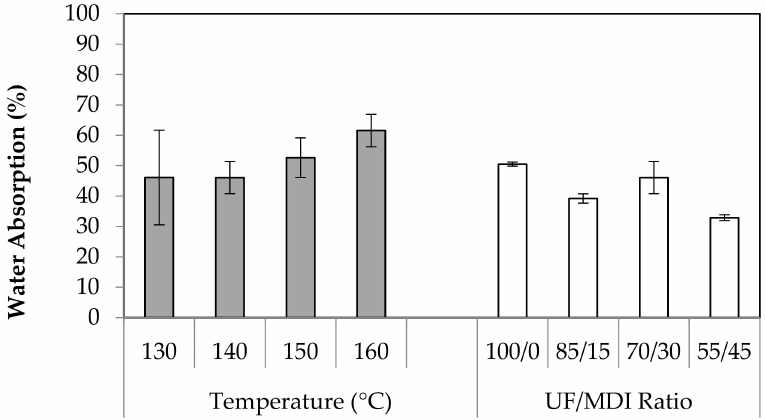
Figure 5. Water absorption of the particleboard. The bars indicate the standard